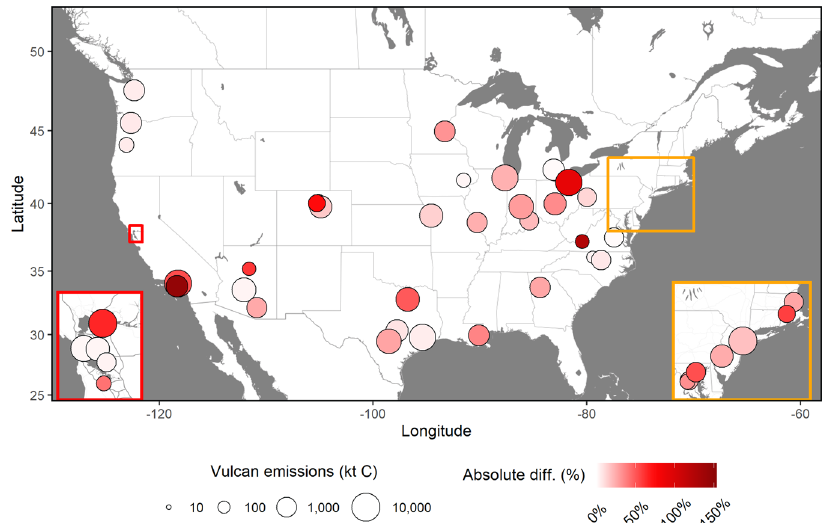
Fig. 1 Total individual city ( N = 48) FFCO 2 emissions and absolute difference (AD = positive RD) between the Vulcan version 3.0 data product and self-reported inventories (SRIs). AD values denoted by color scale and total emissions denoted by circle size. Two regions are expanded (California Bay Area and the Northeast coastal urban corridor) for closer inspection (see “ Methods ” and Source data for additional details). Background map tiles by Stamen Design (no changes made), under CC BY 3.0, data by © OpenStreetMap contributors, under